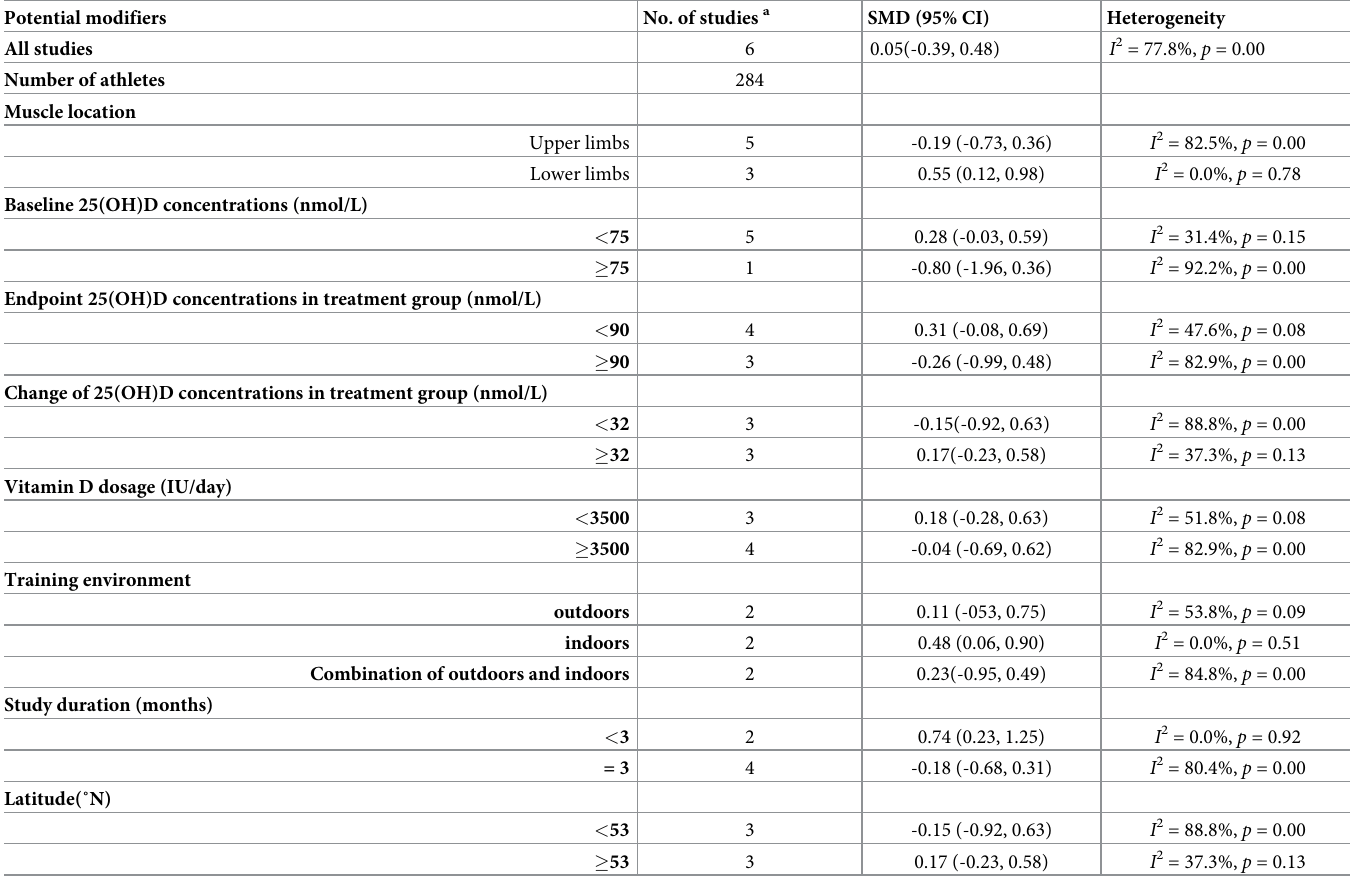
Table 3. Subgroup analysis of muscle strength based on participants’